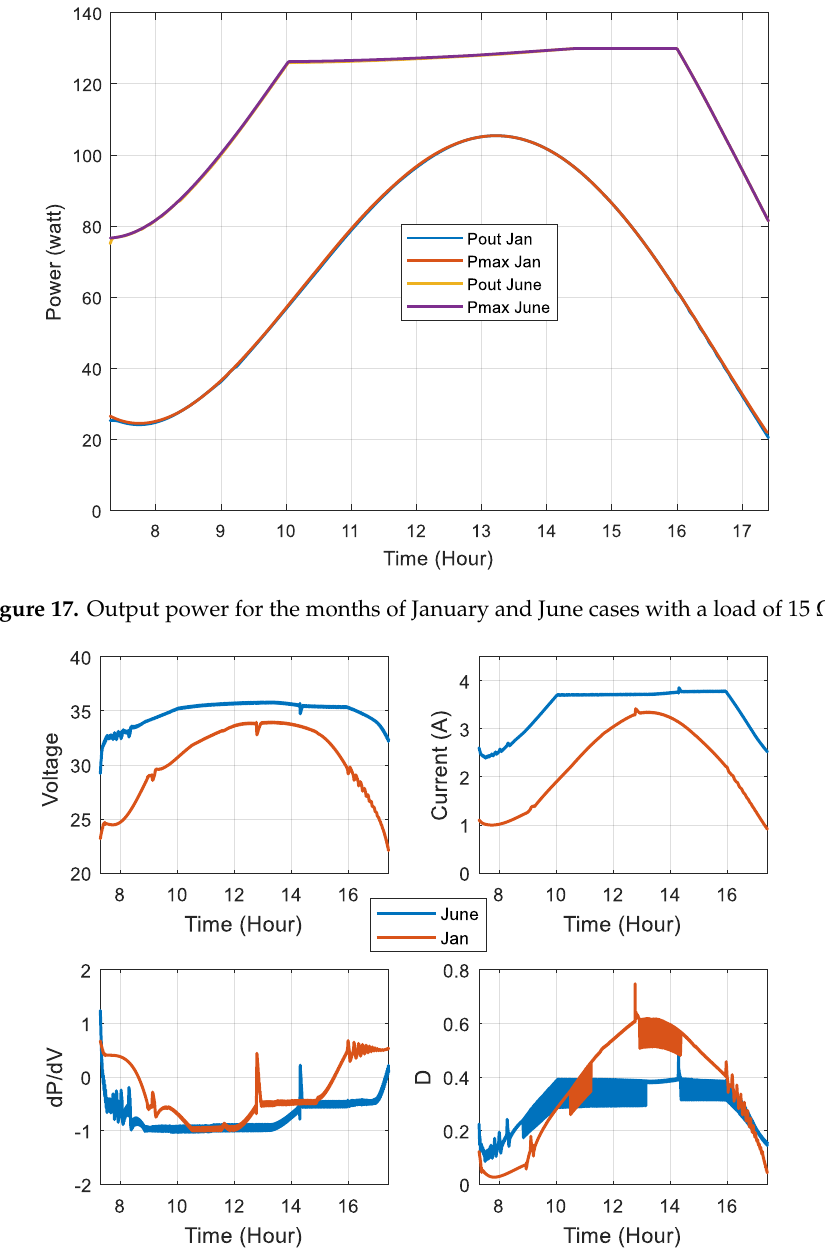
Figure 18. Voltage, current, dP/dV, and D the months of January and June cases with a load of 15 Ω. Figure 18. Voltage, current, dP / dV, and D the months of January and June cases with a load of 15 Ω